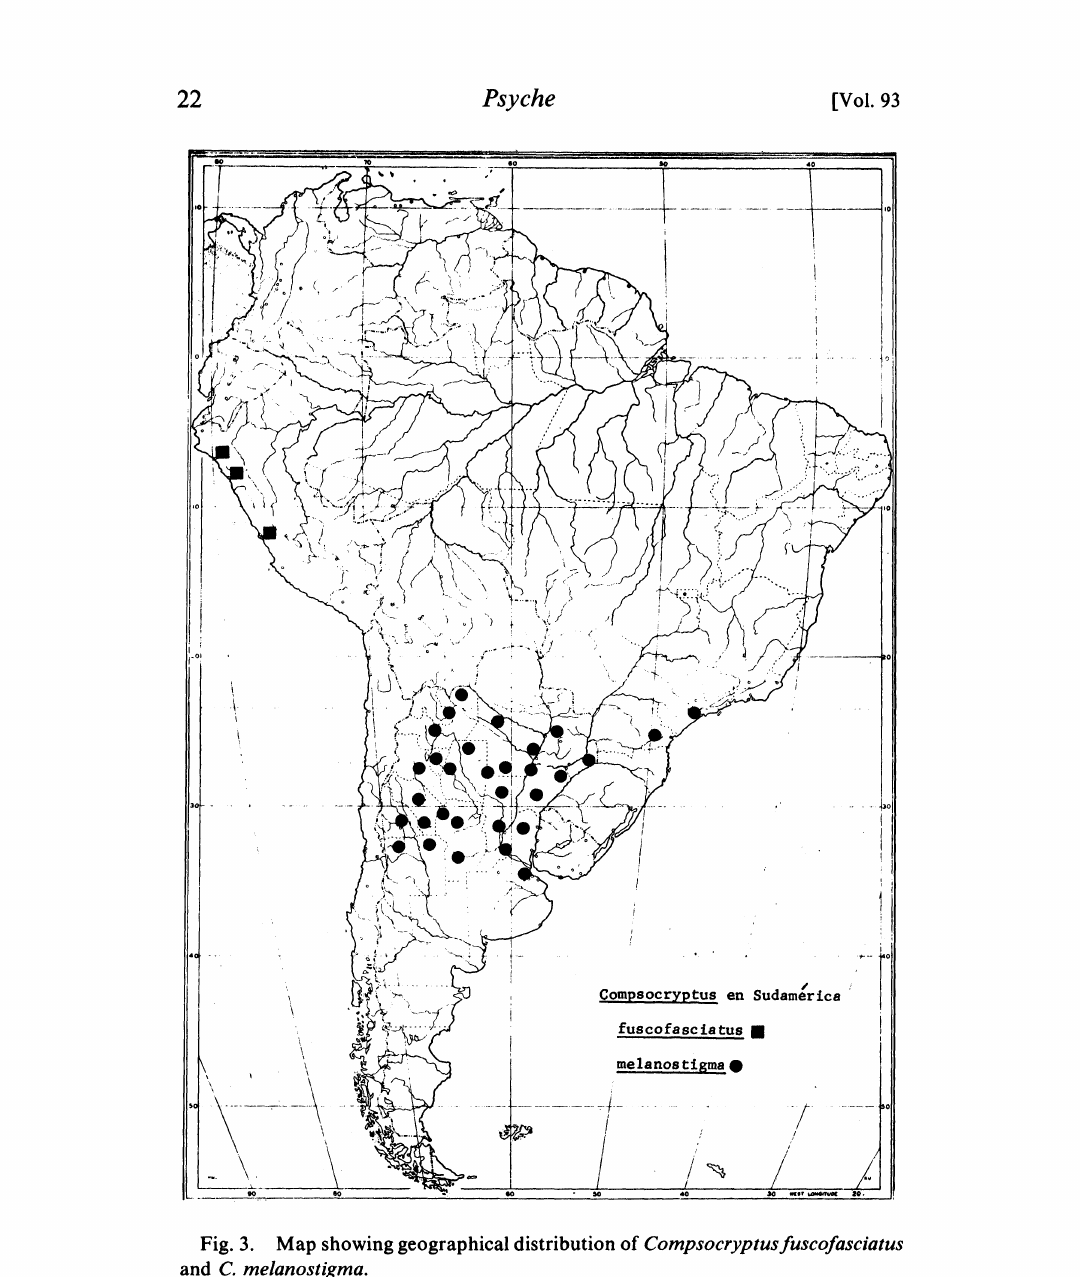
Fig. 3. Map showing geographical distribution of Compsocryptusfuscofasciatus and C.